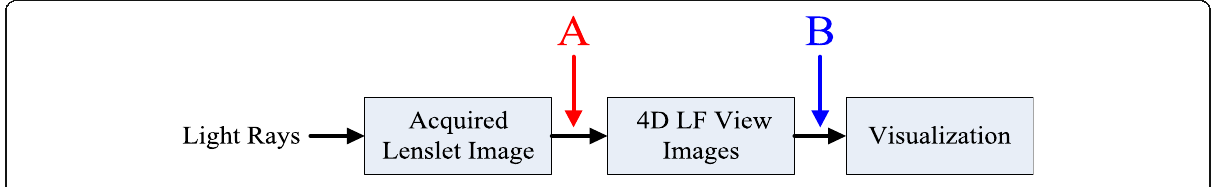
Fig. 1 General acquisition and display pipeline for LF